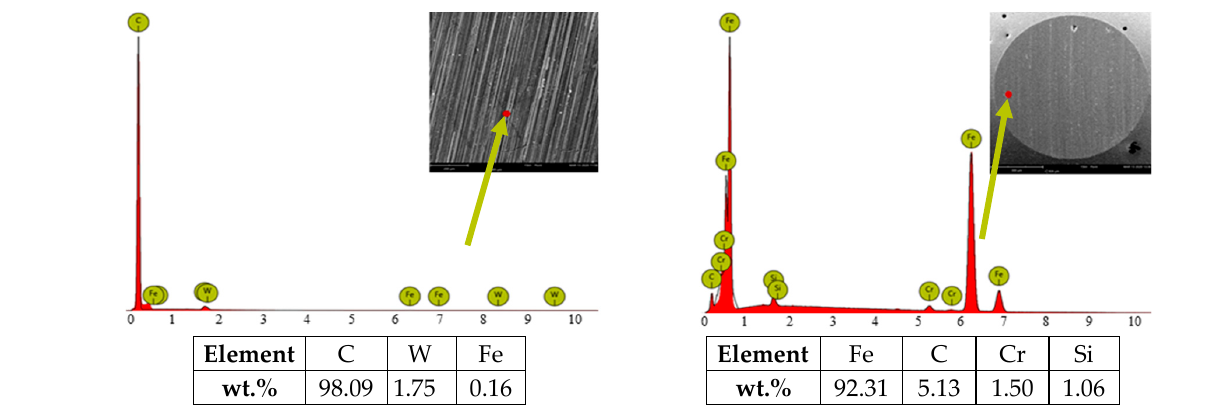
Table 6. Surface texture parameters for ( a ) the uncoated steel discs and ( b ) the W-DLC -coated steel discs in contact with the steel balls before and after the tribological